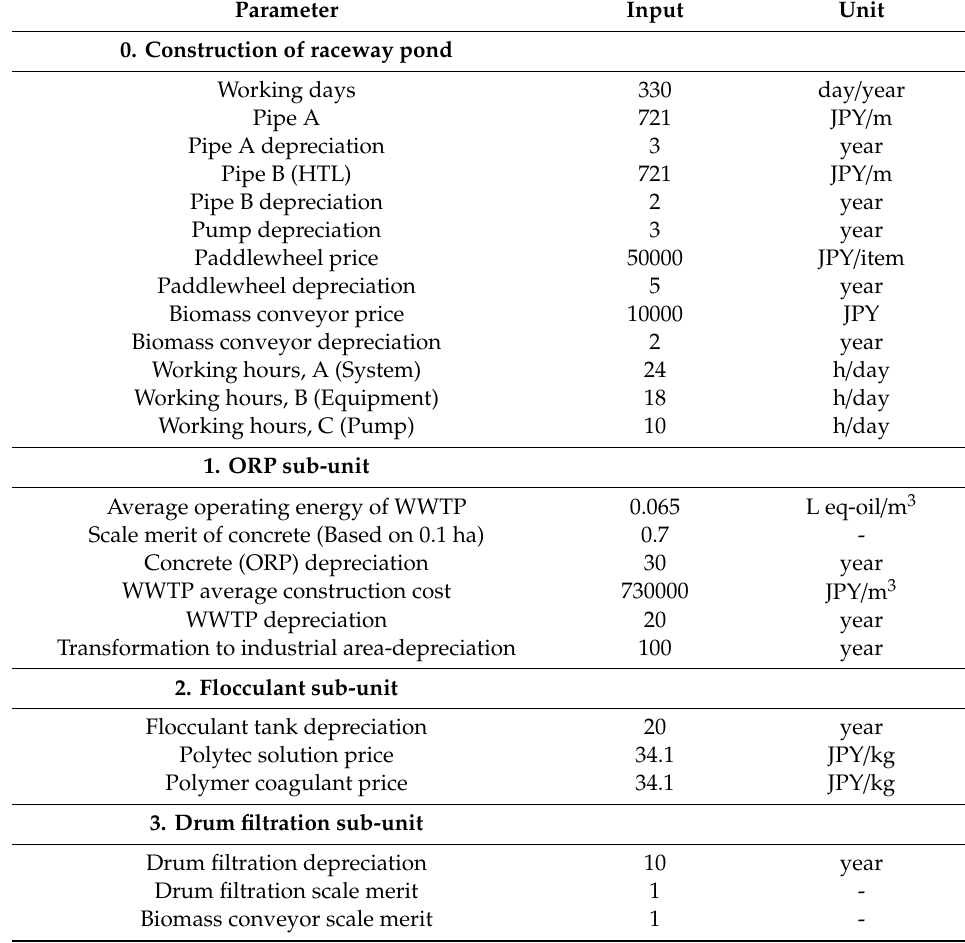
Table A1. Independent parameters for LCA